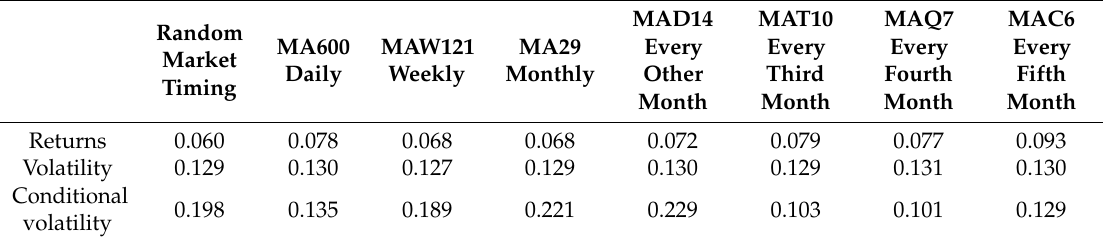
Table 3. The 600 trading-day rolling window, average annualized returns, volatilities, and conditional volatilities in DJIA index, 4 January 1988 to 31 December